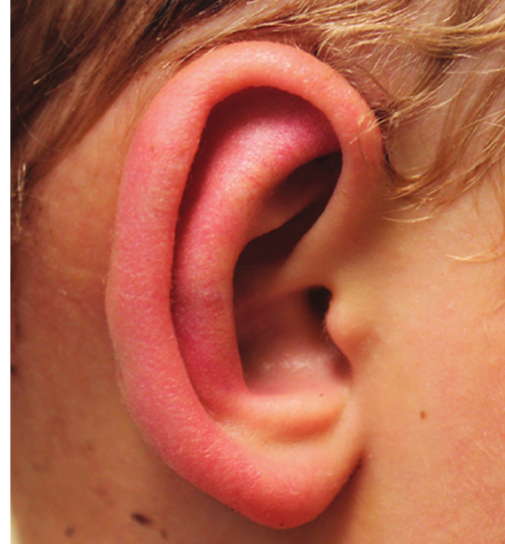
Figure 1: A photograph of the right ear showing mild erythema.